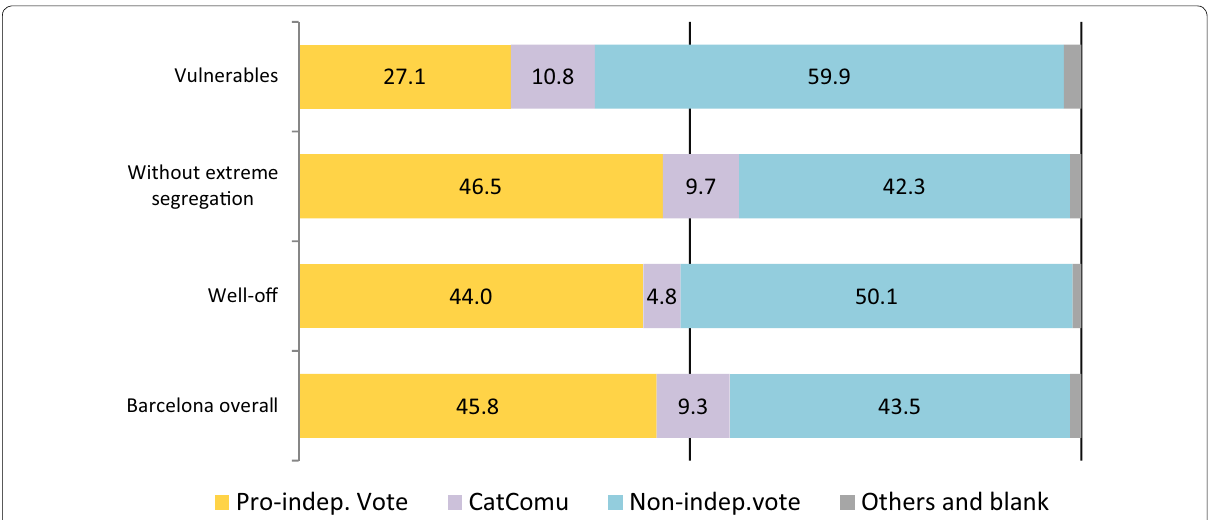
Fig. 4 Elections to the Parliament of Catalonia in December 2017, Barcelona. Results according to the segregation of the census tracts. Pro and non-independence vote [Source: Own elaboration from the data provided by the Generalitat de Catalunya and Barris i crisi (Blanco and Nel